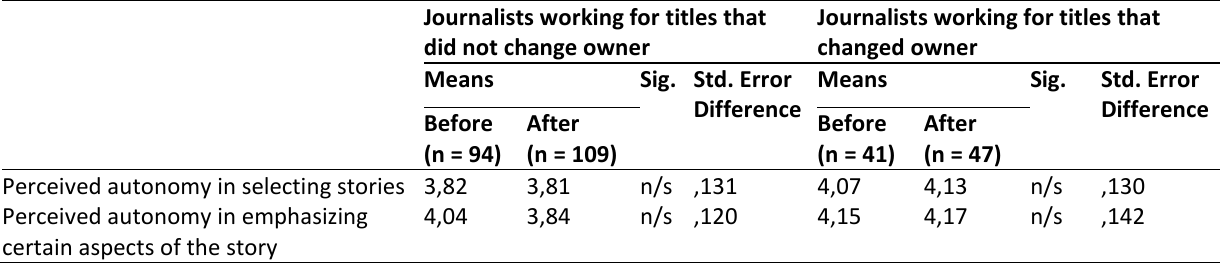
Table 2. Perception of journalistic autonomy before and after the media takeover in 2013 (means, independent samples t-test).